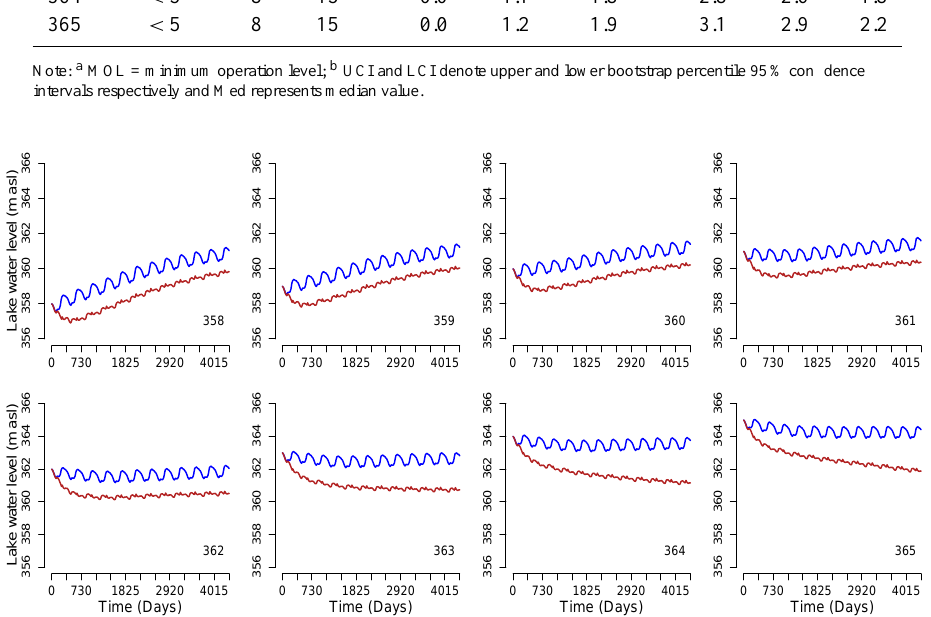
Fig. 6. Impact of the Gibe III dam on the Lake Turkana water levels simulated using the lake level modeling approach and nonparametric bootstrap resampled (NBR) data. The impact of the dam is simulated for different initial lake levels from 358m through 365ma.s.l., shown on the Y-axis. The X-axis shows time (months after the commencement of the dam). The blue line indicates lake level simulated without the dam; the dark red line indicates lake level simulated with the dam.